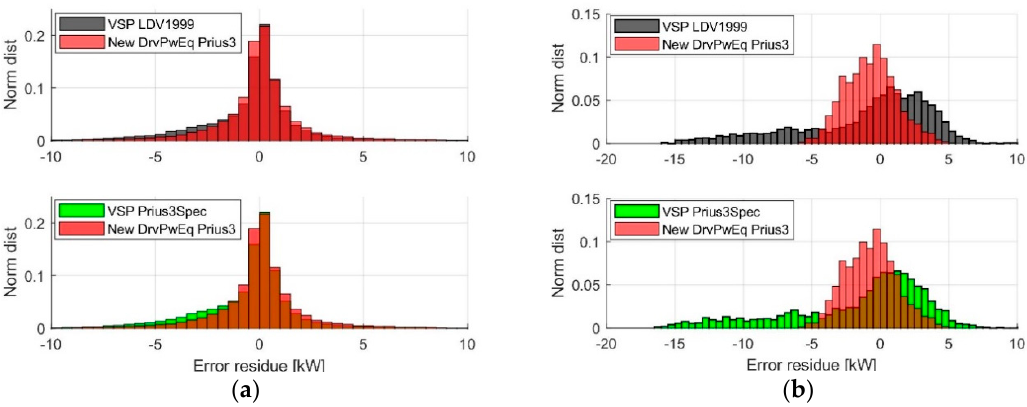
Figure 5. Comparison of error residues from 𝐷𝑟𝑣𝑃𝑤 (cid:3017)(cid:3045)(cid:3036)(cid:3048)(cid:3046)(cid:2871) , VSP Prius3Spec, and VSP LDV 1999. ( a ) Light-load driving (<50 kW) and ( b ) heavy-load driving ( ≥ 50 kW). ( a ) Light-load driving ( < 50 kW) and ( b ) heavy-load driving ( ≥ 50